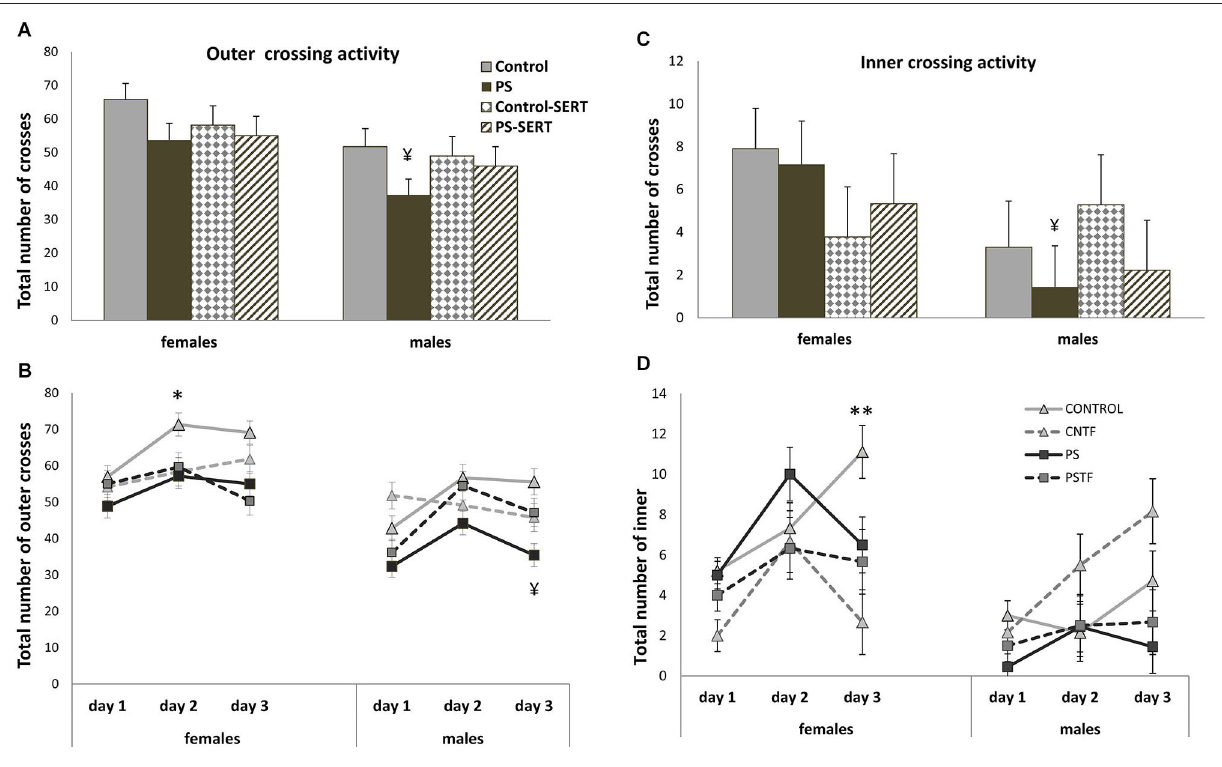
FIGURE 5 | Effects of prenatal stress and SERT treatment on the horizontal activity in the OF test ( n = 8–9 per group and sex) . Means ± standard error for outer crossing activity (panels A and B ) and inner crossing activity (panels C and D ) observed, during 3 min sessions on 3 consecutive days. No differences as effect of prenatal stress or